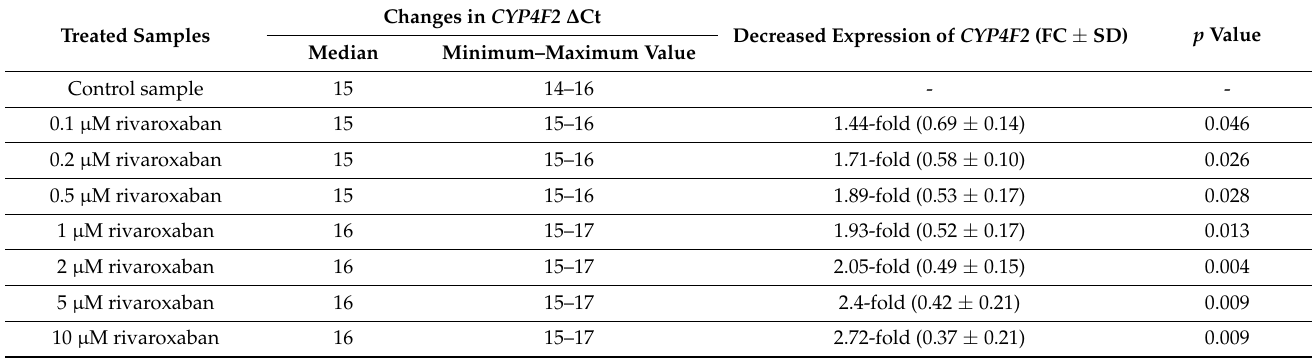
Table 4. Relative changes in the expression ( ∆ Ct) of CYP4F2 after exposure to 0.1, 0.2, 0.5, 1, 2, 5, and 10 µ M rivaroxaban in HUVECs compared to control Figure 2. Number of samples used in gene expression assay.